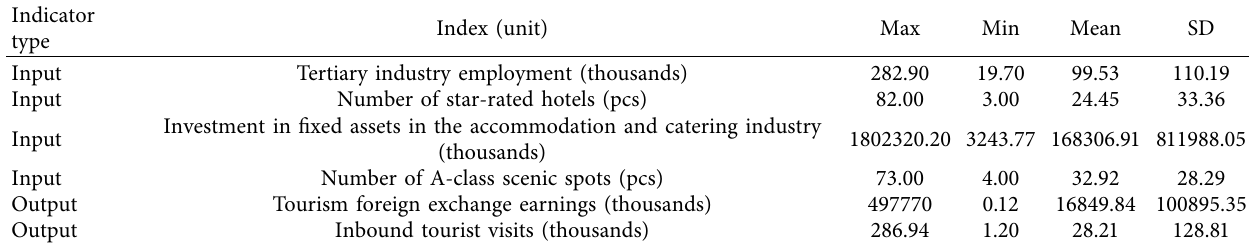
Table 1: Input-output indicators of inbound tourism development efficiency.